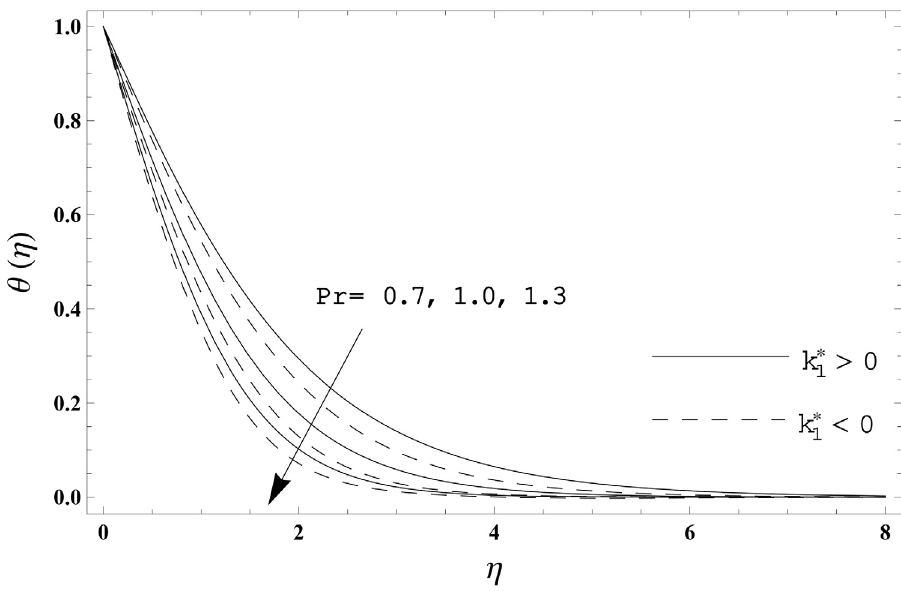
Fig 6. Effect of Pr on θ ( η ) when γ = 0.3.